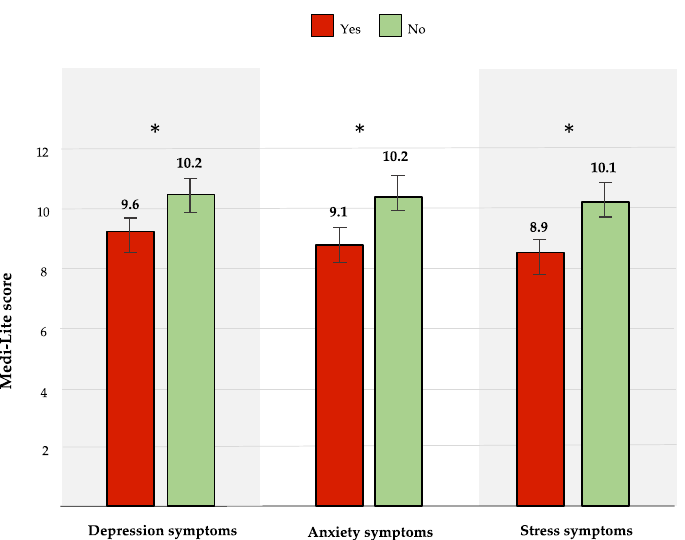
Figure 1. Medi-Lite values according to the presence (in red)/absence (in green) of symptoms of depression, anxiety, and stress, respectively (* p -value < 0.05).